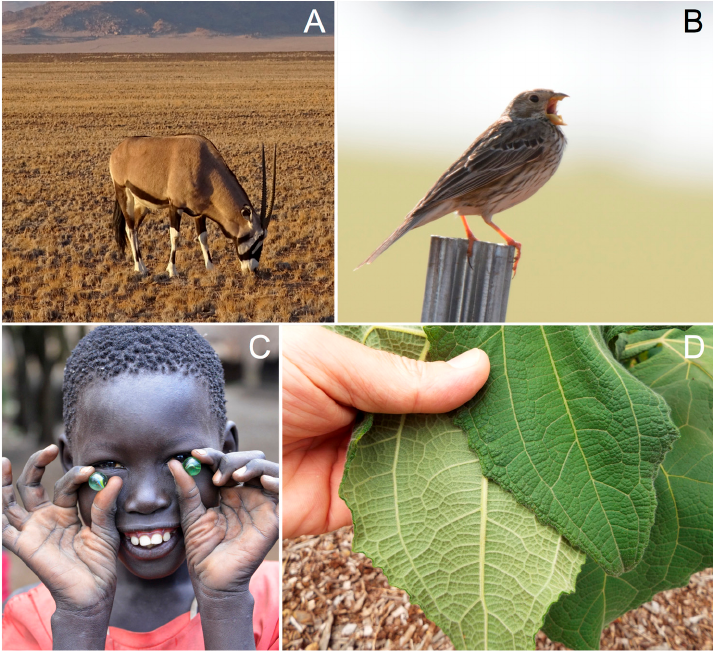
Figure 3. Different examples of contrasting coloration. ( A ) Gemsbok Oryx gazella from Namibia. Grey dorsally, white ventrally (Photograh by Juan J. Negro). ( B ) Corn bunting Emberiza calandra , a brown bird with a light belly (Photograph by Ismael Galván). ( C ) Dark-skinned person showing lighter coloration in the palms of the hands (credit and link: Rod Waddington; Available online: https://flic.kr/p/i3CAuX; covered by a CC BY-SA license (Available online, site last accessed 22/01/2018: https://creativecommons.org/licenses/by-sa/2.0/). ( D ) Yac ó n Smallanthus sonchifolius with a high color contrast between the upper side and underside of the leaves (credit and link: Forest and Kim Starr; https://flic.kr/p/DtS3hR; covered by a CC BY license (Available online, site last accessed